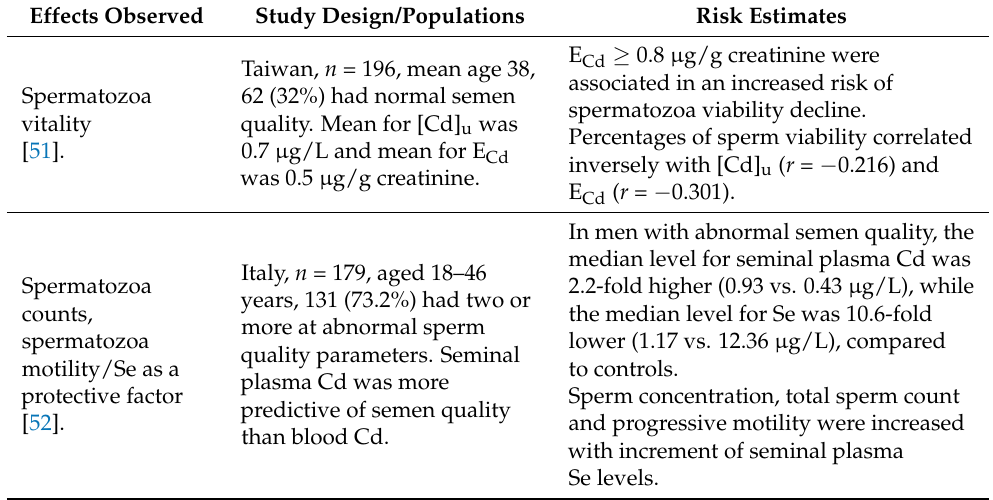
Table 3. Epidemiological evidence for the effects of cadmium on semen